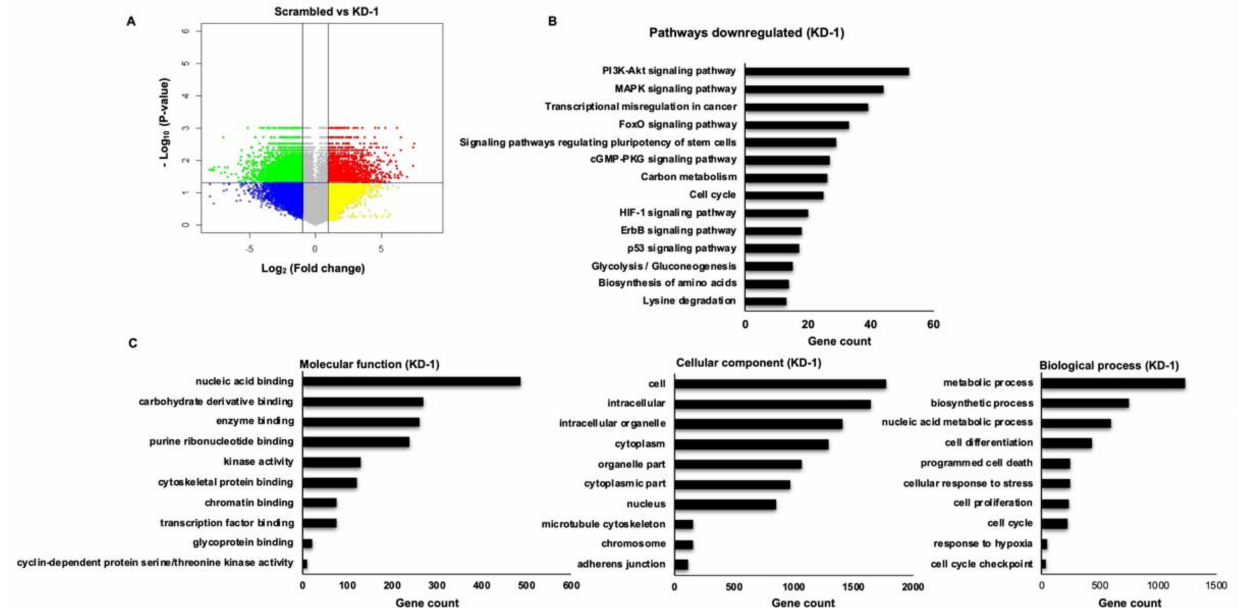
Figure 5. Microarray analysis of differentially expressed genes (DEGs). ( A ) Volcano plot constructed using fold change and p -values to compare the gene expression changes between scrambled and MYCN knockdown (KD-1) Y79 cells. The green spots indicate significantly downregulated genes with log 2 (fold change) < − 1 and p -value < 0.05, and red spots represent the significantly upregulated genes with log 2 (fold change) > 1 and p -value < 0.05. the yellow and blue spots indicate the non-significant changes in gene expression. ( B ) KEGG pathway enrichment analysis of downregulated DEGs upon MYCN knockdown. ( C ) GO functional enrichment analysis of downregulated DEGs in response to MYCN knockdown. GO terms are enriched into three subgroups: Molecular function, Cellular component and Biological process. KEGG: Kyoto Encyclopedia of Genes and Genomes, GO: Gene